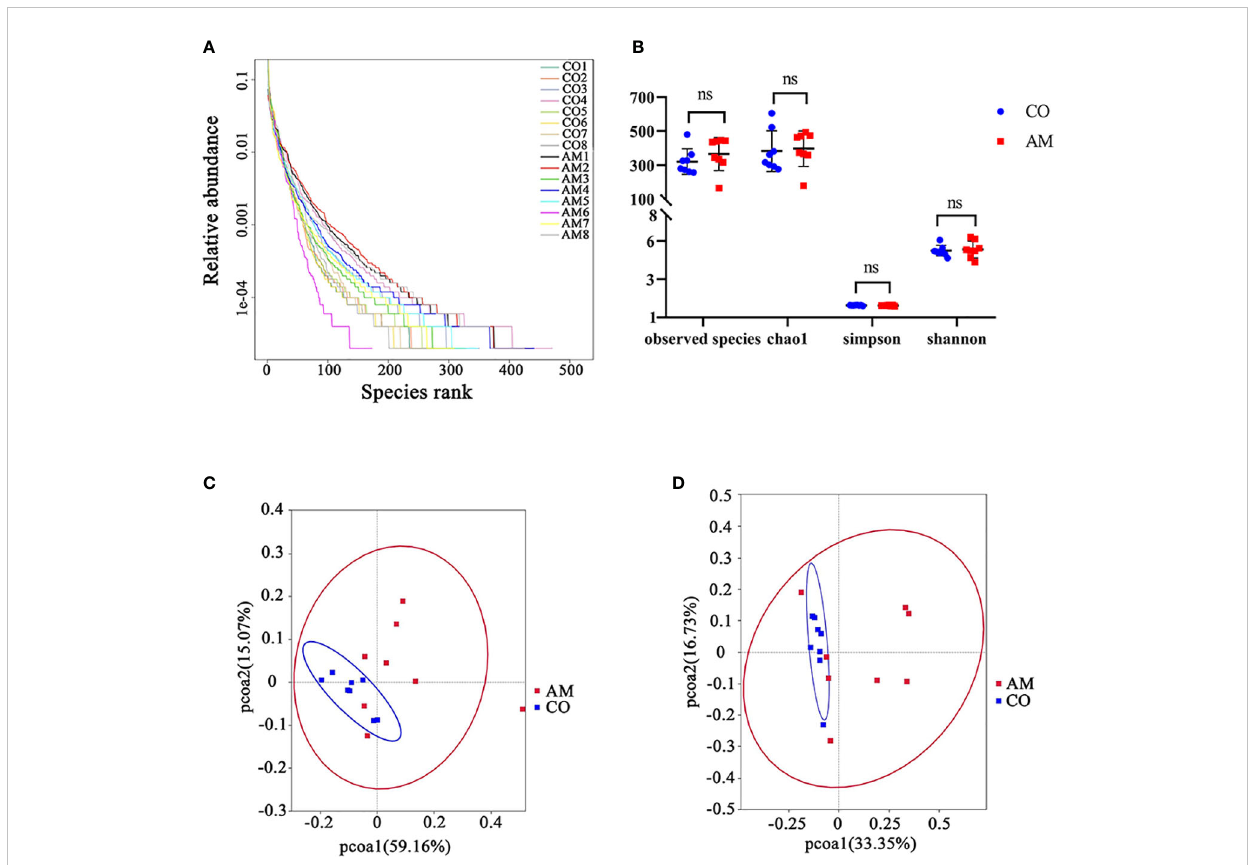
FIGURE 2 Diversity analysis of gut microbiota in control and AM groups. (A) Rank-abundance curves. The abscissa position of the extension endpoint of the sample curve was the number of OTU. (B) Boxplot of alpha diversity (Observed species, Chao1, Shannon, and Simpson index) for gut microbiota. Weighted uniFrac PCoA plots (C) and unweighted uniFrac PCoA plots (D) . PC1 and PC2 represented the two suspected in fl uencing factors of microbial composition migration. The percentage represented the contribution of principal coordinate components to sample composition differences. The closer the two sample points were, the more similar the species composition of the two samples was. ns, not signi fi cantly